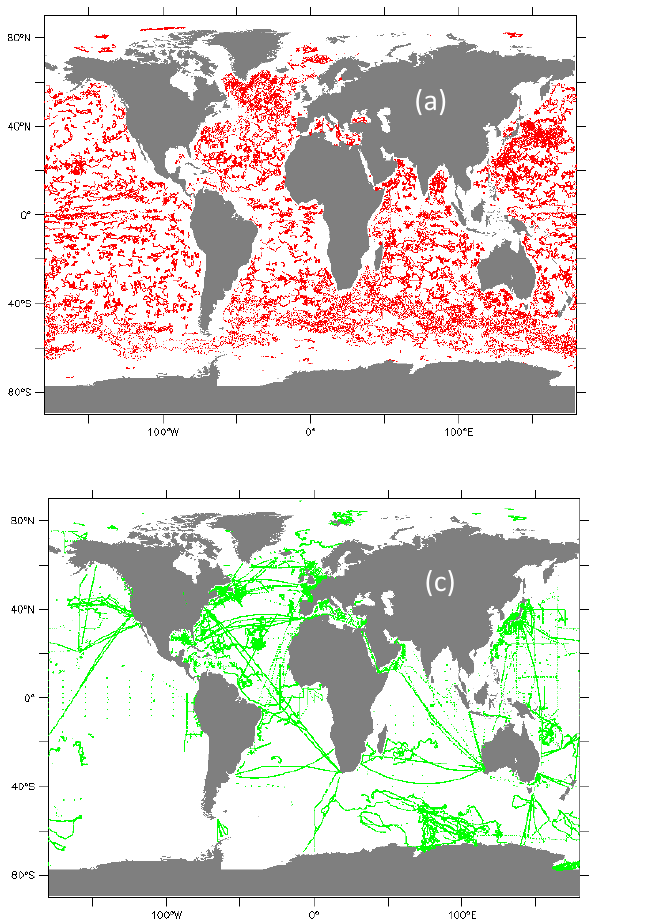
Figure 1. Spatial distribution of 2012 in situ data set divided into three sub-data sets. Red dots are the Argo profiles from odd WMO (World Meteorological Organization) platform numbers, blue dots are Argo profiles from even WMO platform numbers, green dots are the other in situ